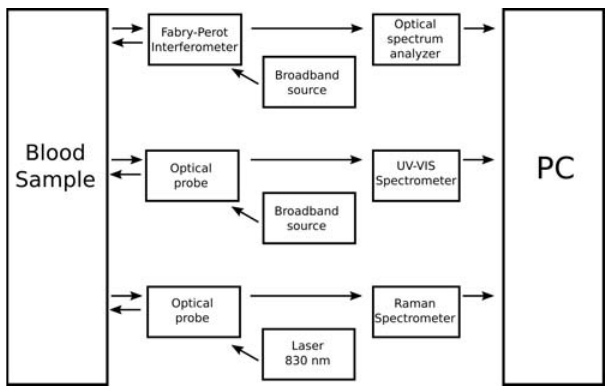
Fig. 1. The layout of experimental setup: low-coherence in- terferometer (top part of image), optical absorption spectrom- eter (middle part of image), Raman spectrometer (bottom part of